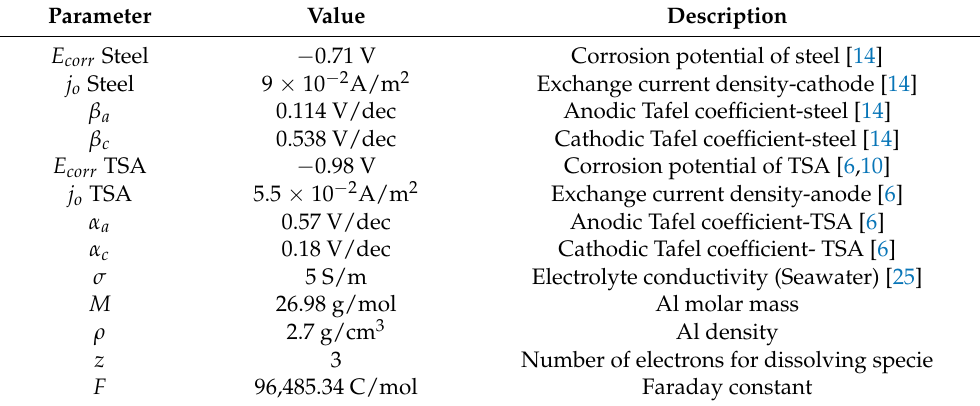
Table 1. Parameters used in the model. Potentials are referred to Ag/AgCl (Sat. KCl).